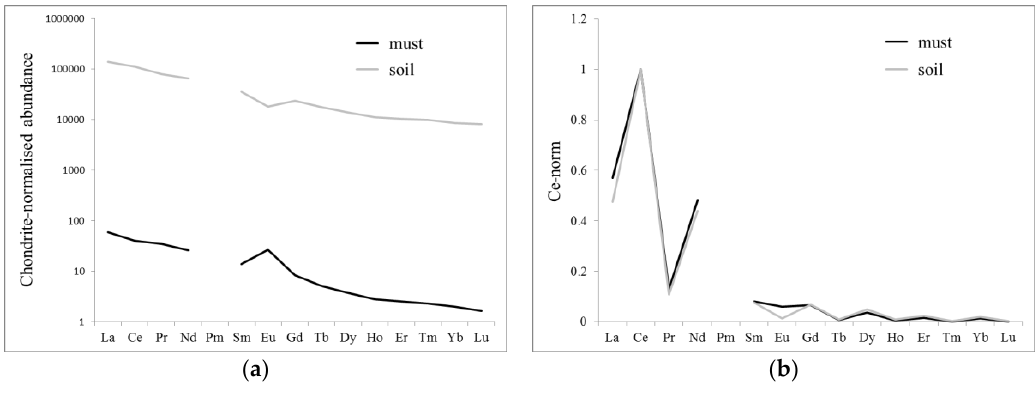
Figure 3. REE distributions in must and in soil: ( a ) chondrite-normalized values; ( b ) Ce-normalized values.